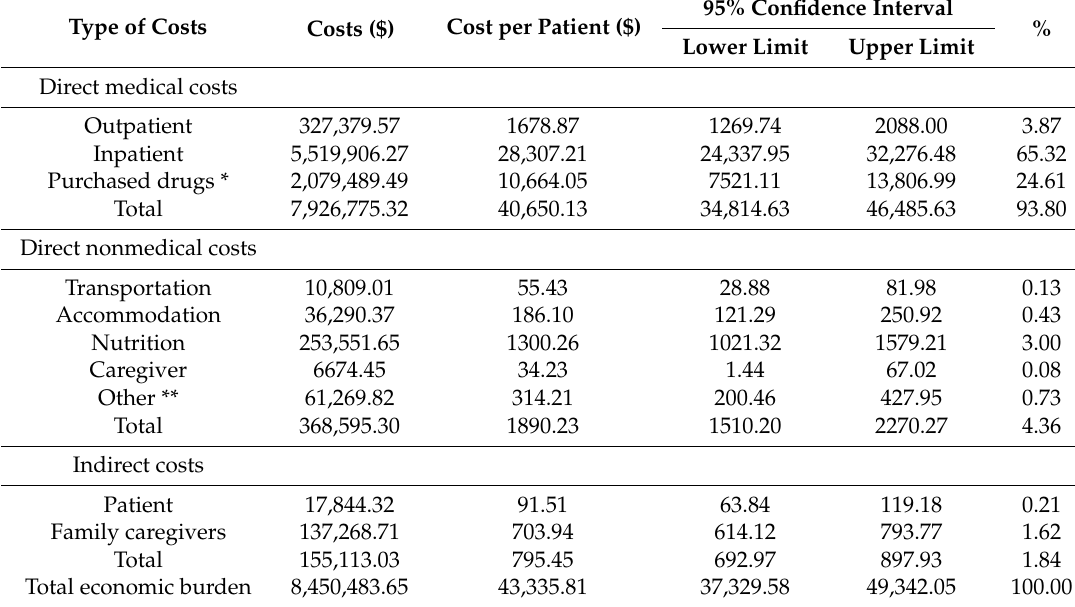
Table 2. Total economic burden of 195 lung cancer